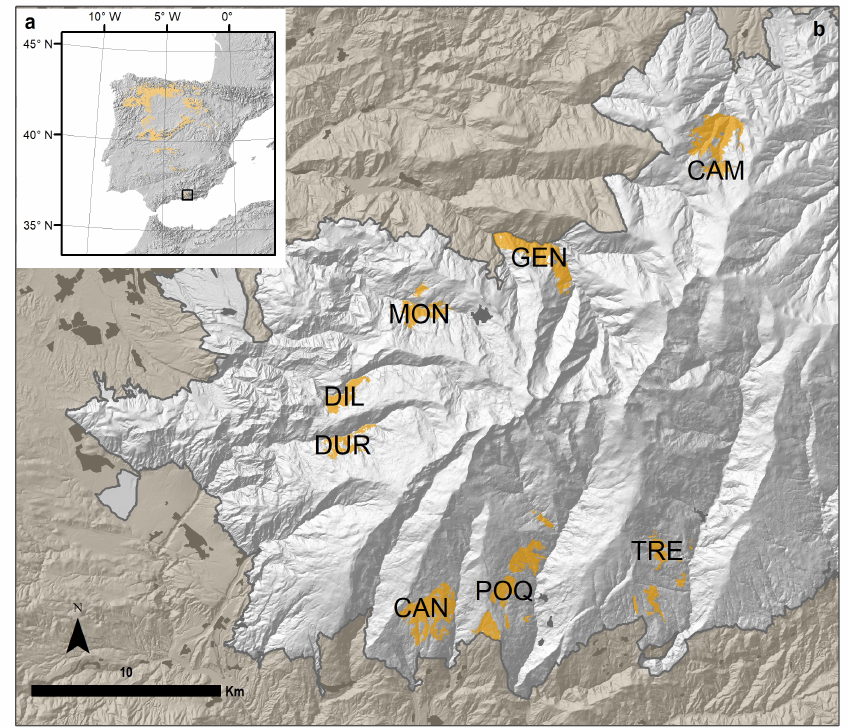
Figure 1. Distribution of Quercus pyrenaica forests in the Iberian Peninsula ( a ) and location of the patches in Sierra Nevada mountain range ( b )—the name of each population as in Table